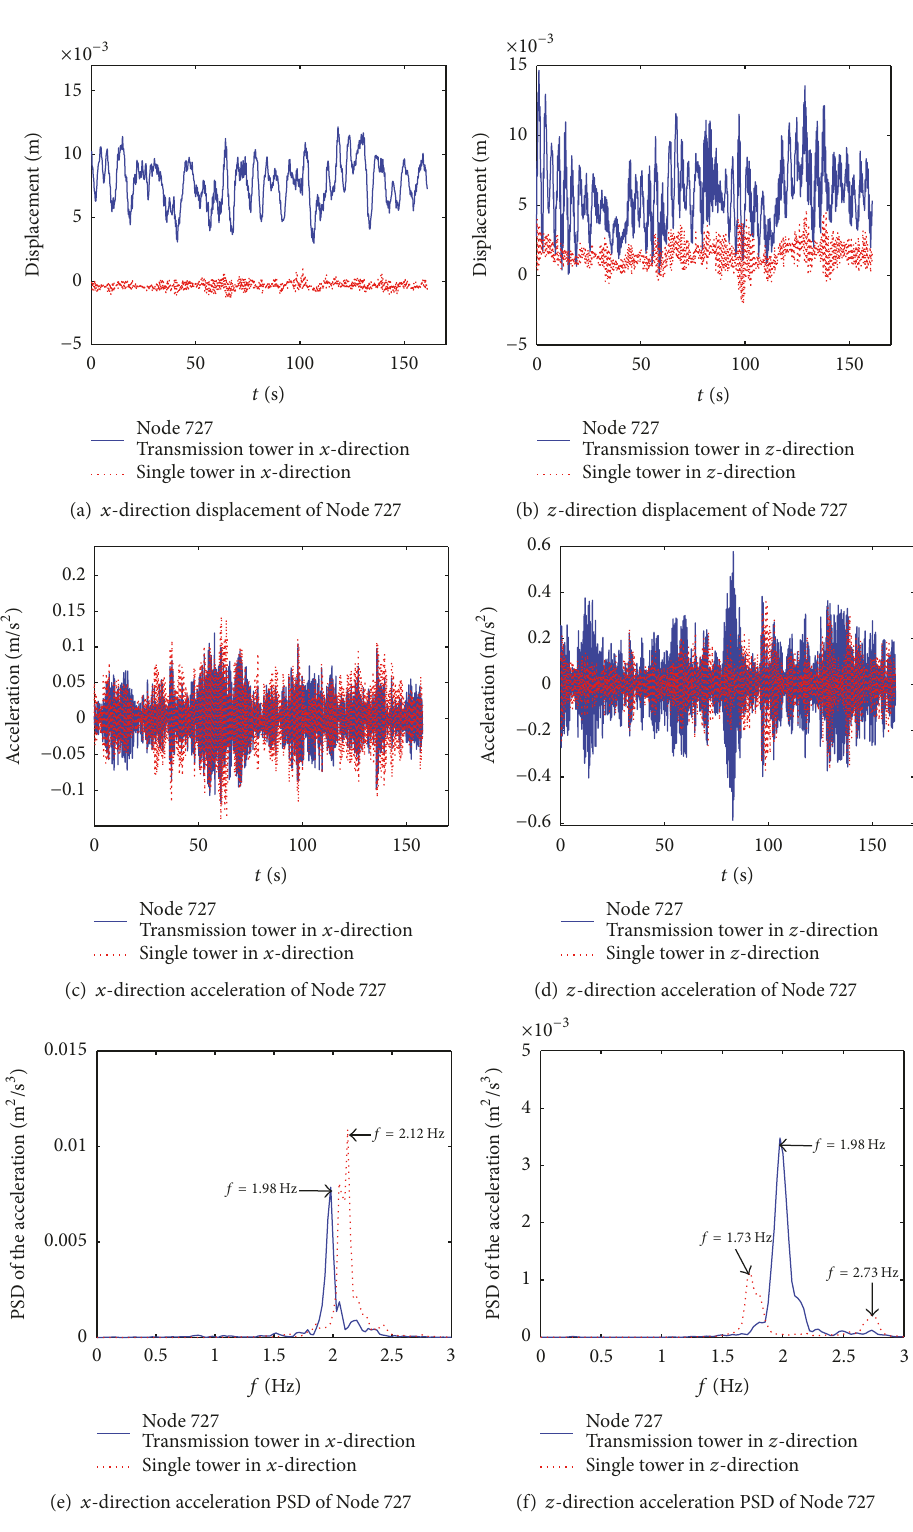
Figure 16: Steady-state response of Node 727 of the tower under a wind speed of 𝑈 10 = 6.03